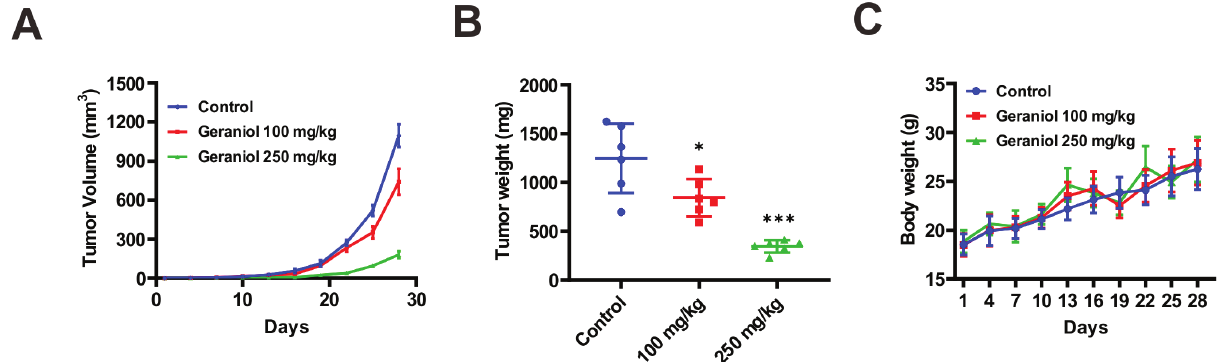
Fig. 5. The anticancer effect of geraniol in nude mice inoculated with UM1 cells. (A) The tumor volume was measured every 3 days. (B) The tumor weight was measured at the end of the experiment. (C) The body weight of mice was measured every 3 days. * P < 0.05 and *** P < 0.001, compared with the control group.